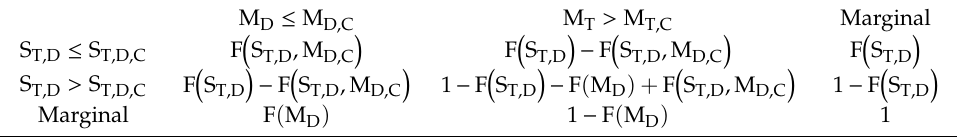
Table 1. Relationships between agricultural drought severity and meteorological flux